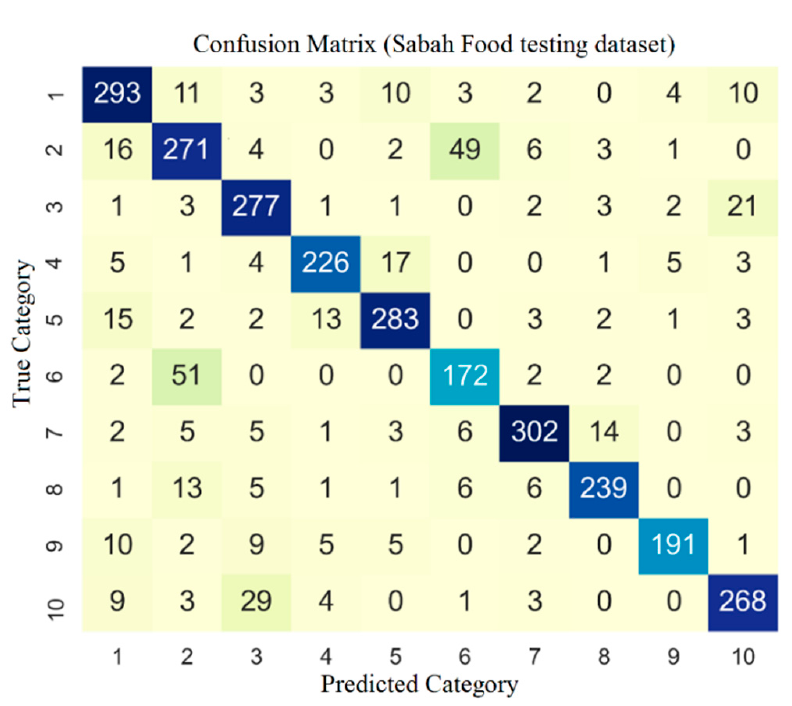
Figure 5. Confusion matrix of EFFNet + CNN applied on Sabah food testing set.